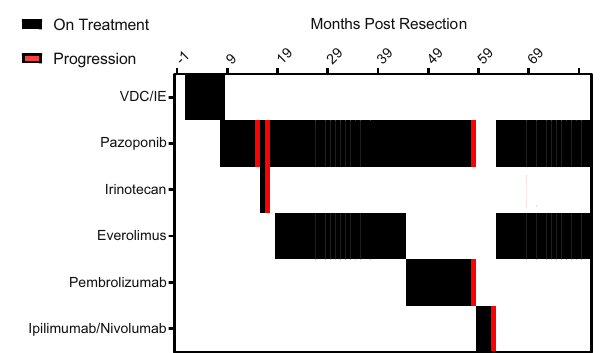
Fig. 5 Treatment timeline of a 58-year-old man diagnosed with an EWSR1-NFATc2 fusion positive sarcoma. Treatment history for a 58-year-old man diagnosed with an EWSR1-NFATc2 gene fusion positive sarcoma. Genomic characterization also revealed a single pathogenic variant in FANCE . Brie fl y, following surgical excision, this patient received little bene fi t from adjuvant therapy of alternating vincristine, doxorubicin, and cyclophosphamide (VDC), followed by ifosfamide and etoposide (IE). Pazopanib alone and in combination with irinotecan provided little clinical bene fi t. Combination treat- ment with pazopanib and everolimus stabilized disease for 26 months before progression. Pembrolizumab in combination with pazopanib then stabilized disease for ten months before further disease progression, while further therapy with ipilimumab plus nivolumab provided disease stabilization for four months. The patient was then re-challenged with pazopanib and everolimus and has continued on this therapy for 21 months without progression before passing away due to causes unrelated to his active